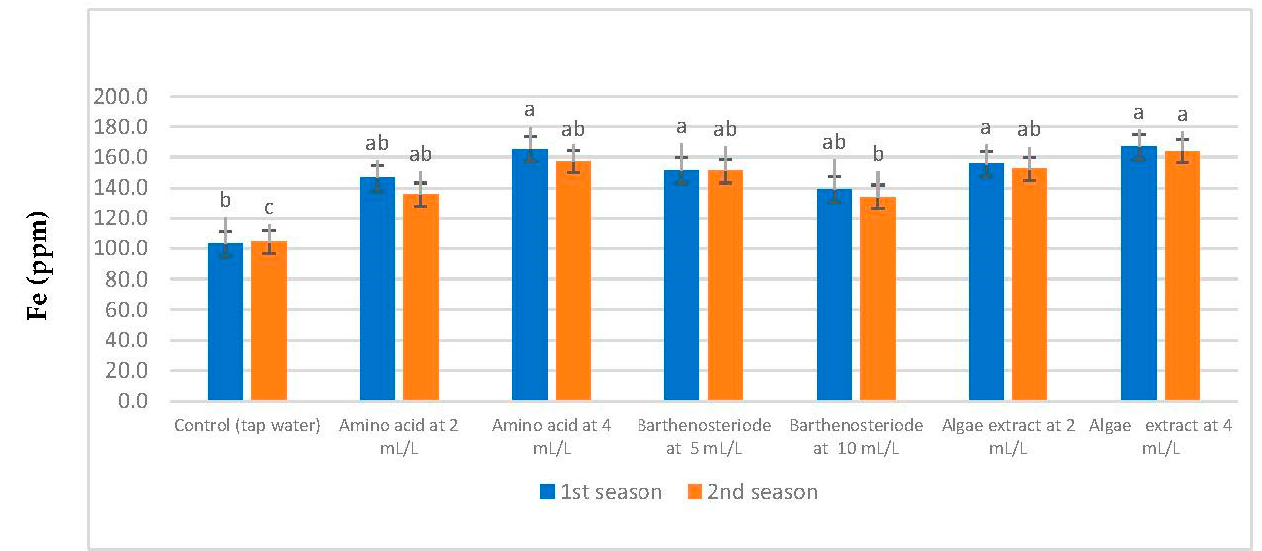
Figure 8. Effect of various bio-stimulant treatments on Fe (ppm) of chia ( Salvia hispanica L.) plants during the 2019–2020 and 2020–2021 seasons. For the same column, means followed by the same letter are not statistically different, according to the Tukey multiple range test.